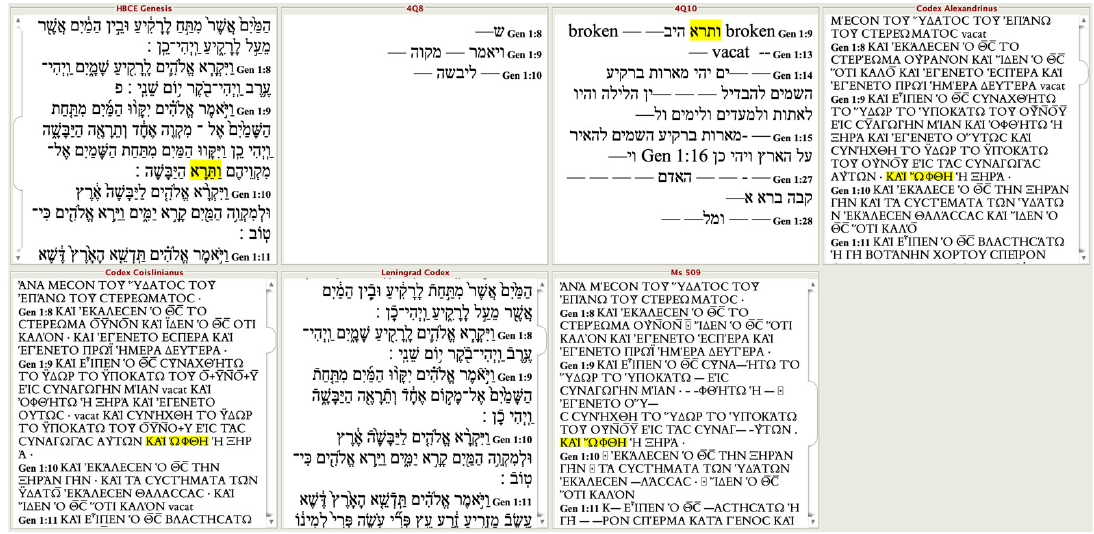
Figure 18: A second comparison across languages Once again we check the transcriptions against the primary evidence in the images of the manuscripts.